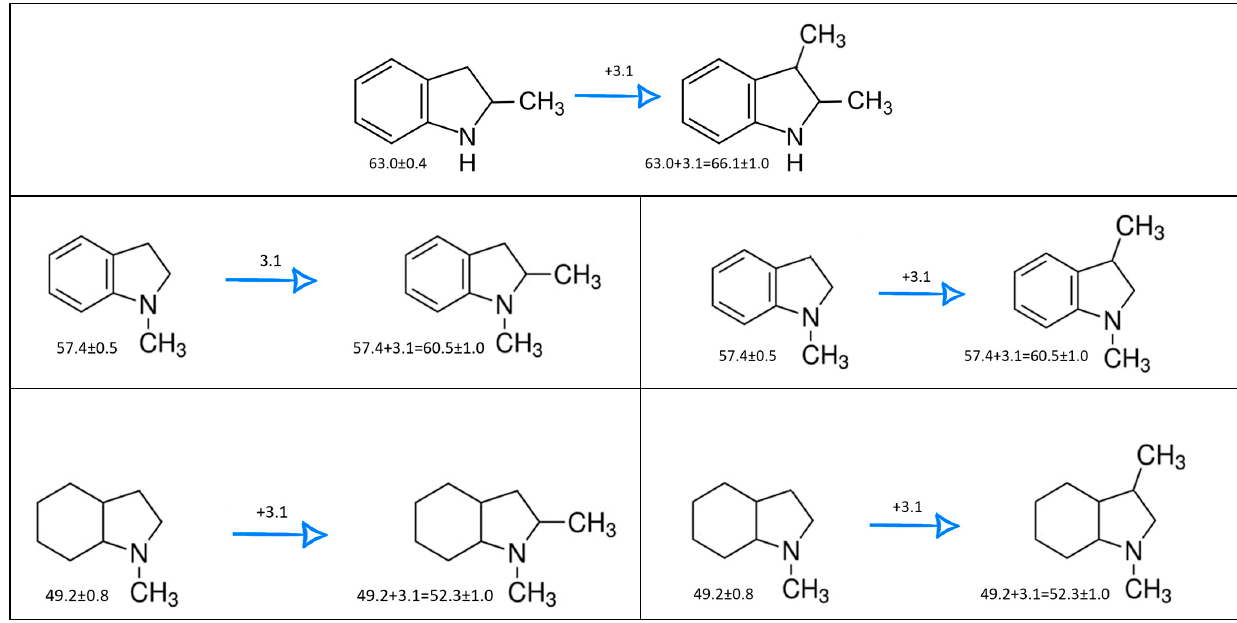
Figure 4. Application of the “centerpiece” approach to estimate the vaporization enthalpies, ∆ lg 𝐻 mo (298.15 K), of 2,3-dimethyl-indoline, 1,2-dimethyl-indoline 1,3-dimethyl-indoline, 1,2-dimethyl-(H8)-indole and 1,3-dimethyl-(H8)-indole. Numerical values are given in kJ·mol − 1 at T = 298.15